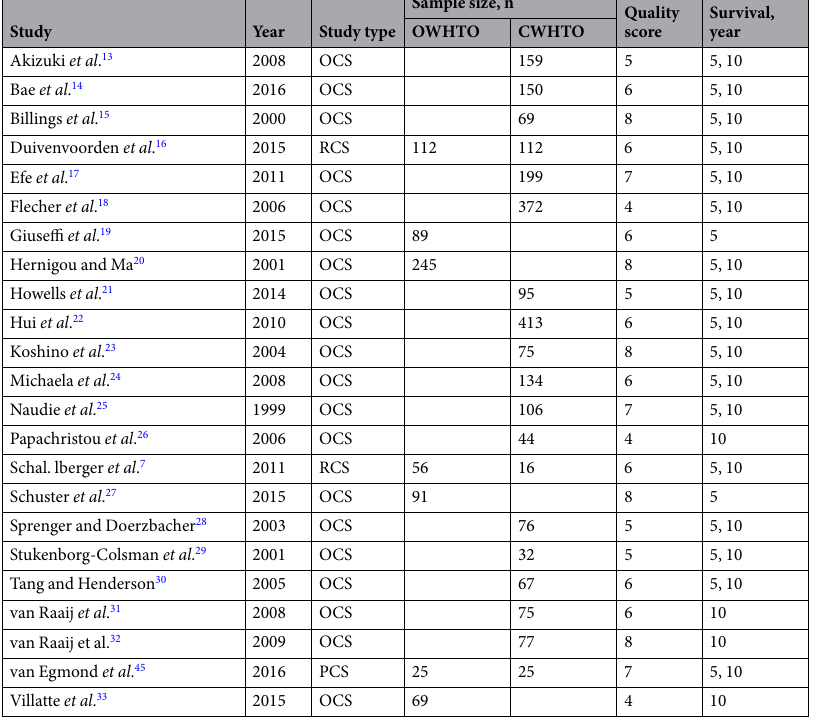
Table 1. Summary of study characteristics. CWHTO, closed-wedge high tibial osteotomy; OWHTO, open- wedge high tibial osteotomy; OCS, observational case series; RCS, retrospective comparison study; PCS, prospective comparison study